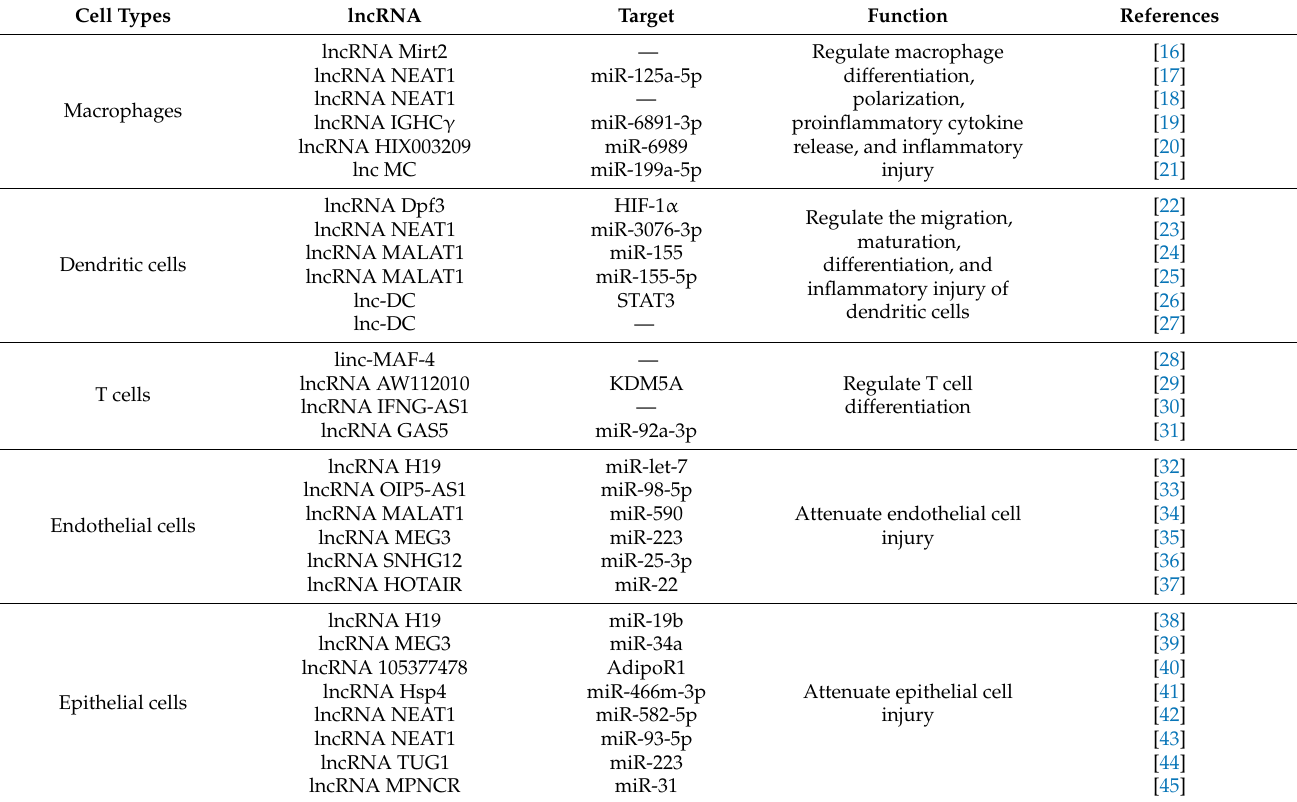
Table 1. Function of intracellular long noncoding